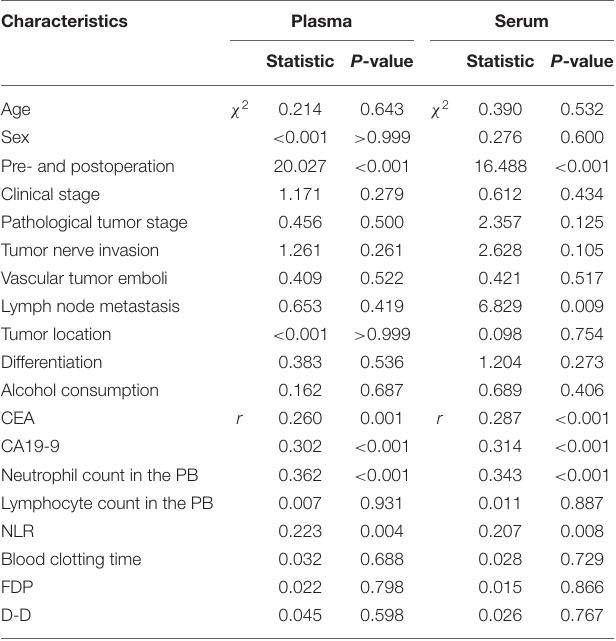
TABLE 6 | The relationships between the levels of NETs in the PB and clinicopathological features in GC patients who underwent surgery.